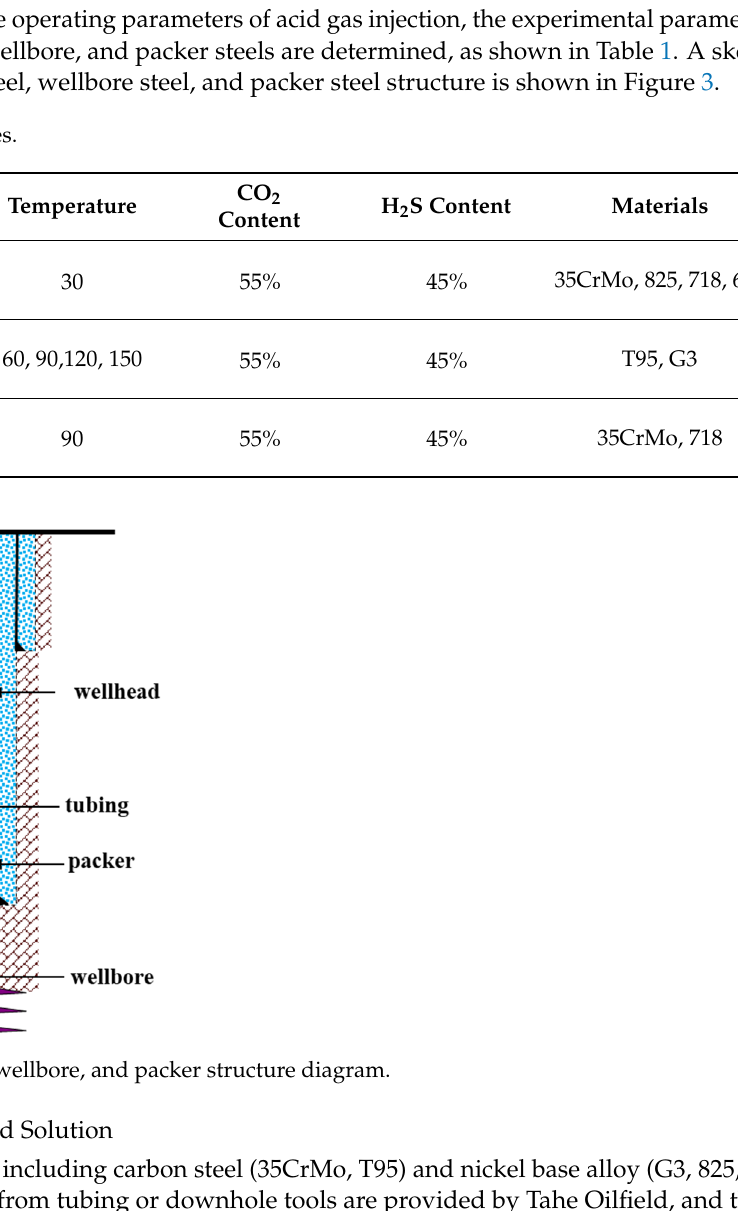
Figure 2. Material selection chart of tubing in Q/SH 0015 standard. Note: J55, N80, and 13Cr are widely used in the oil industry. SM2535 represents UNS N08535, SM2550 represents UNS N07750, and G3 represents UNS N06985. All materials adopt Q/SH 0015 ‐ 2006 standard and API Specification 5CT or ISO 11960 2014 standard.